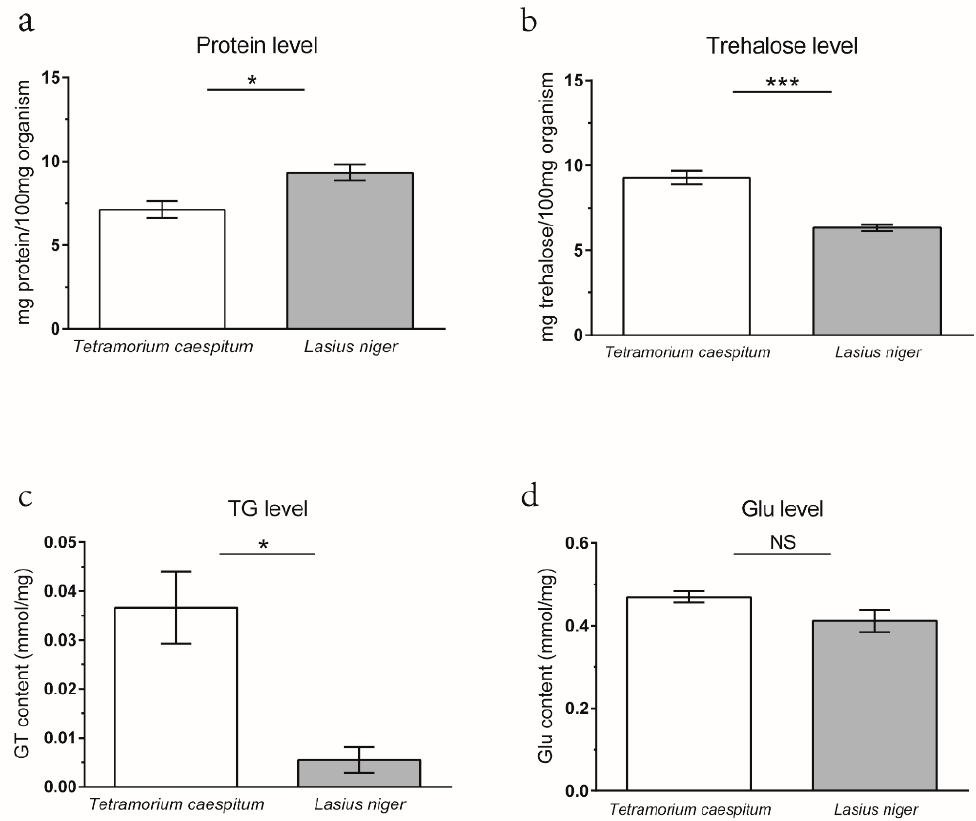
Figure 1. The content of protein ( a ), trehalose ( b ), TG (triglyceride) ( c ), and glucose ( d ) in Tetramorium caespitum and Lasius niger . Asterisks indicate statistically significant differences (* p < 0.05; *** p < 0.001); NS, not significant. Each measurement contains six to eight